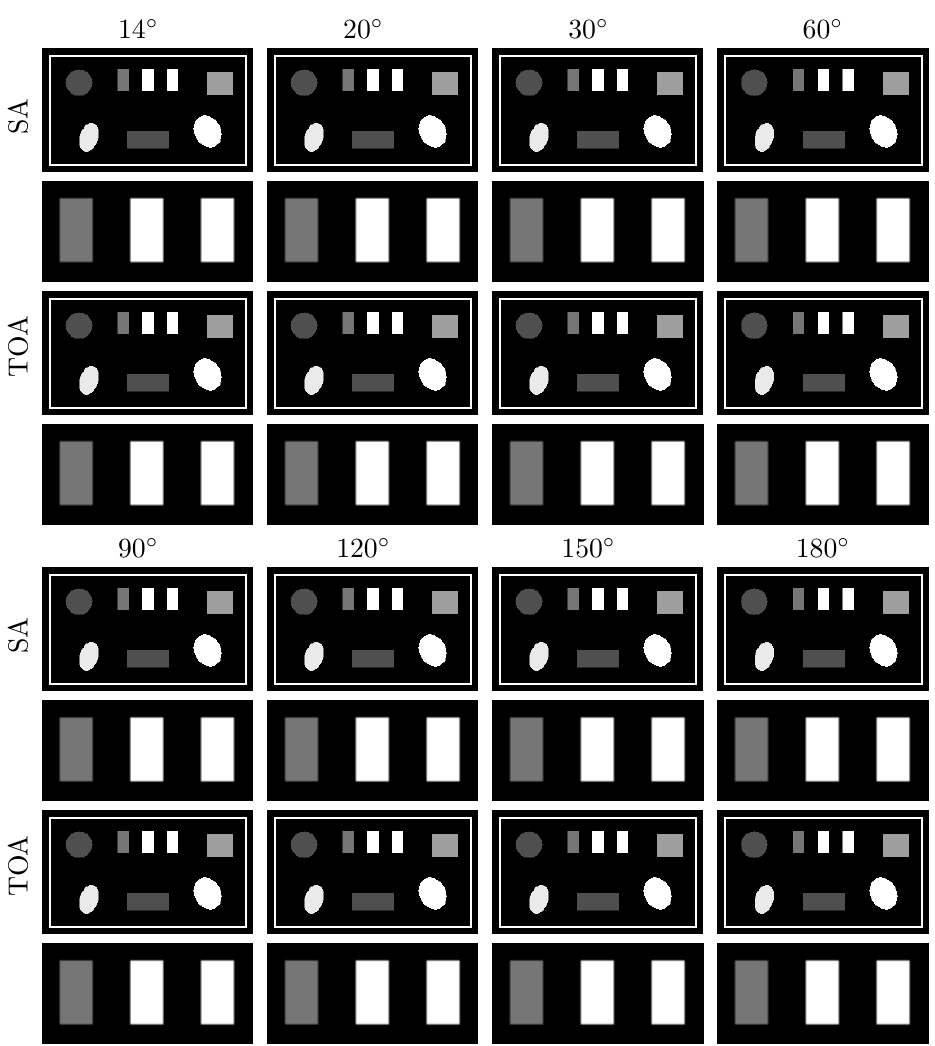
Figure 9. VMIs (rows 1, 3, 5, and 7), along with their respective zoomed-in views (rows 2, 4, 6, and 8), of the suitcase phantom at 40 keV obtained from noiseless data acquired over SAs (rows 1&2 and 5&6) and TOAs (rows 3&4 and 7&8) of LAR 14 ◦ , 20 ◦ , 30 ◦ , 60 ◦ , 90 ◦ , 120 ◦ , 150 ◦ , and 180 ◦ , respectively, by use of the two-step method. Display window: [0.1, 0.65] cm − 1